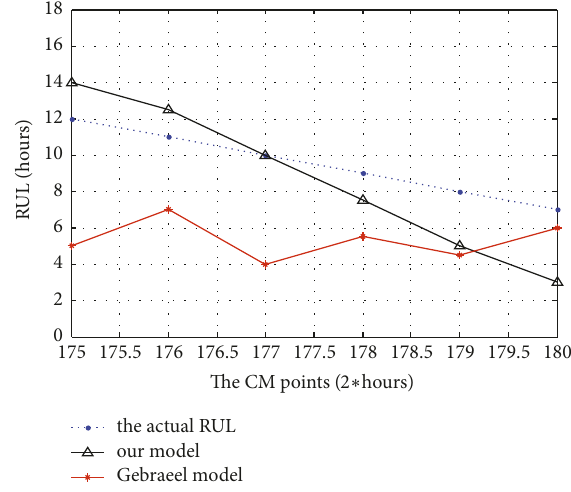
Figure 3: The estimated mean RUL and the actual RUL at last 6 CM points.